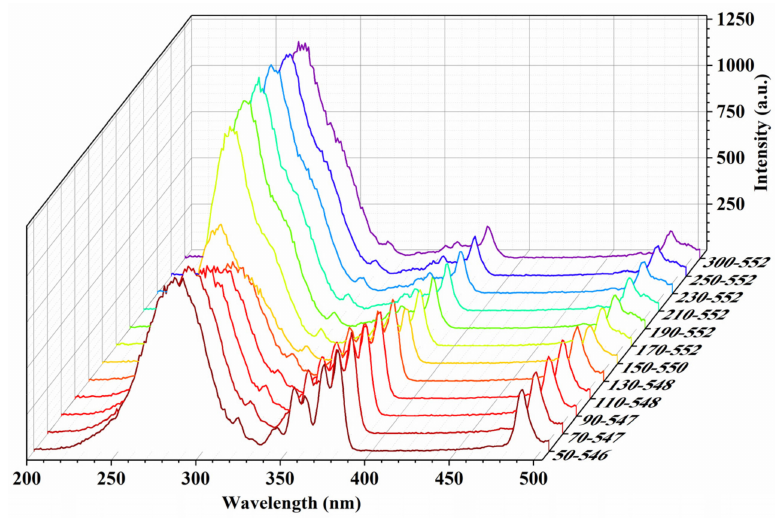
Figure 13. Measuring temperature-dependent PL excitation spectra of Tb 3+ -doped Lu 2 W 3 O 12 pre- pared at 1000 ◦ C.